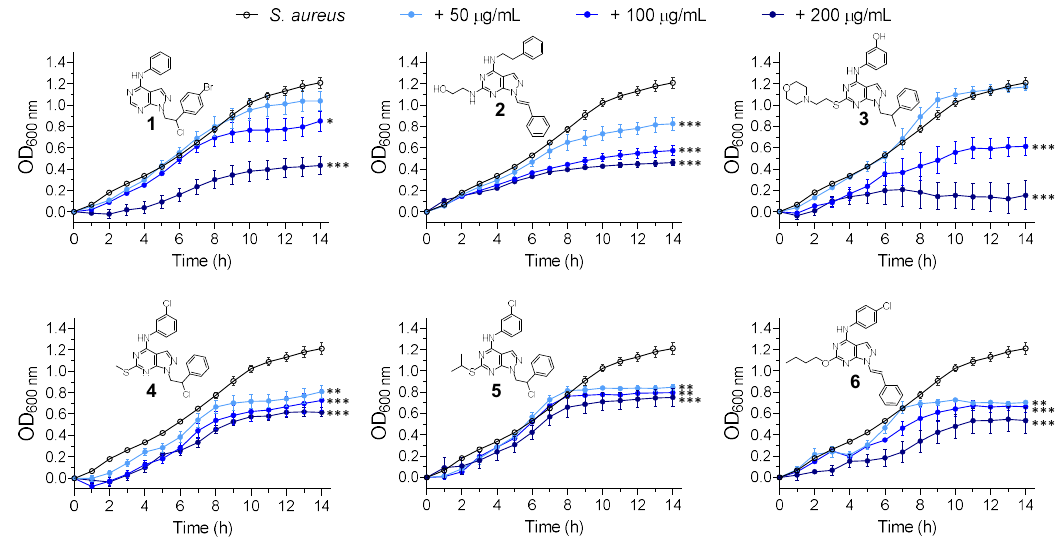
Figure 3. Growth curves of S. aureus in the presence of increasing concentrations (50, 100 and 200 µ g / mL) of pyrazolo[3,4- d ]pyrimidines (compounds 1 – 6 ). Data are representative of at least 3 independent repeat experiments. Error bars indicate SEM. p -values of significance (* < 0.05, ** < 0.01 and *** < 0.001) were determined using one-way analysis of variance (ANOVA). OD: optical density.